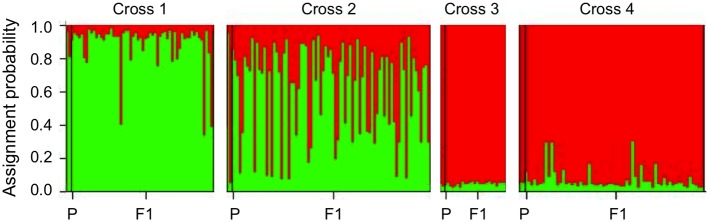
Population genetic structure of Pseudo-nitzschia multistriata parental strains and samples of their F1 offspring [21] as identified by Structure.For each cross, parental and F1-strains are grouped in boxes, ordered along the x-axis. Each vertical bar in a box represents one strain; the first two bars represent the parental strains, the remainder, the F1 strains. The y-axis indicates the proportion of a strain’s genome assigned by Structure to POP_A (green) and POP_B (red). Strains not assignable to one of these populations at or above the 0.9-probability-level are considered putative hybrids based on the Structure results. Parental strain assignment according to Structure: Cross 1: SY017 (POP_A; green)×SY278 (hybrid); Cross 2: SY017 (POP_A; green)×SY138 (POP_B; red); Cross 3: SY138 (POP_B; red)×SY378 (POP_B; red); and Cross 4: SY138 (POP_B; red)×SY379 (POP_B; red).